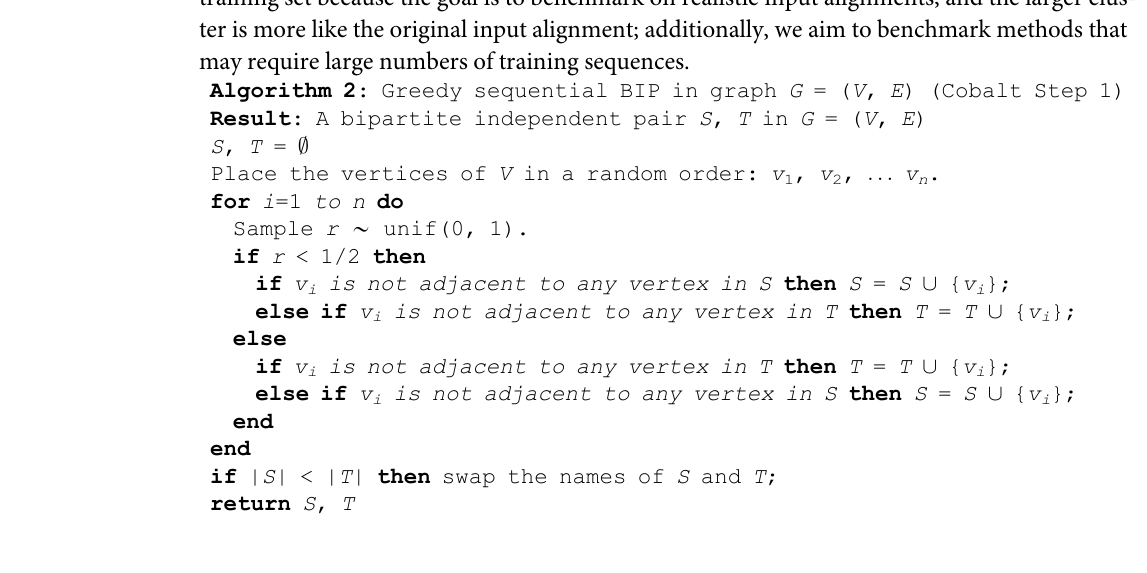
Algorithm 2 : Greedy sequential BIP in graph G = ( V , E ) (Cobalt Step